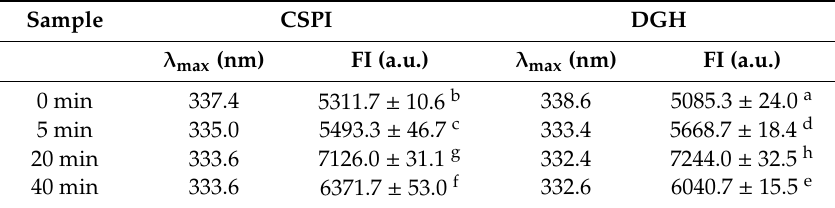
Table 4. E ff ect of high-intensity ultrasound treatment (20 kHz at 400 W for 0, 5, 20, 40 min) on the λ max and fluorescence intensity (FI) of CSPI and